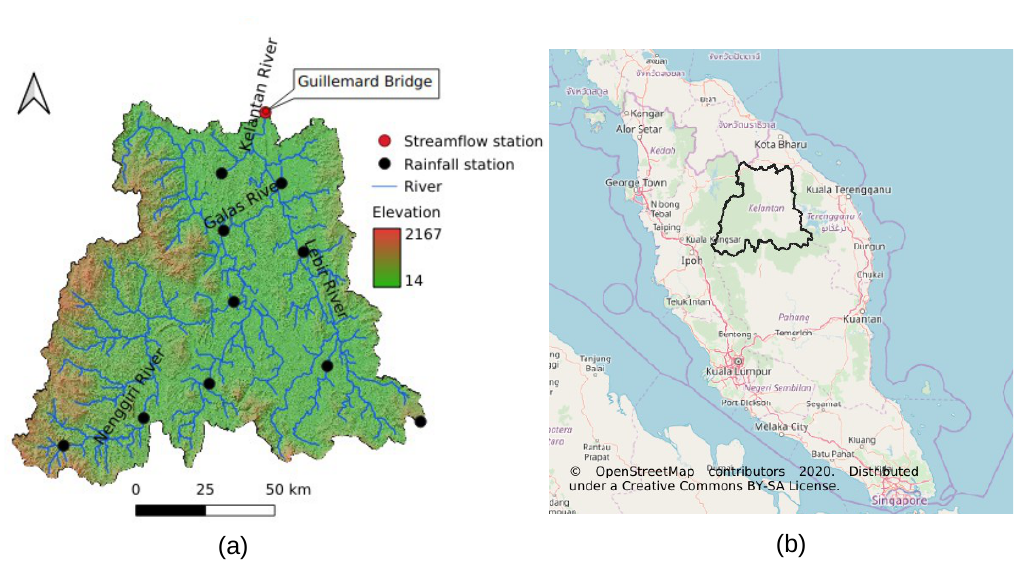
Figure 1. ( a ) Kelantan River network and catchment with rainfall and streamflow stations, ( b ) The Kelantan catchment location in Peninsular